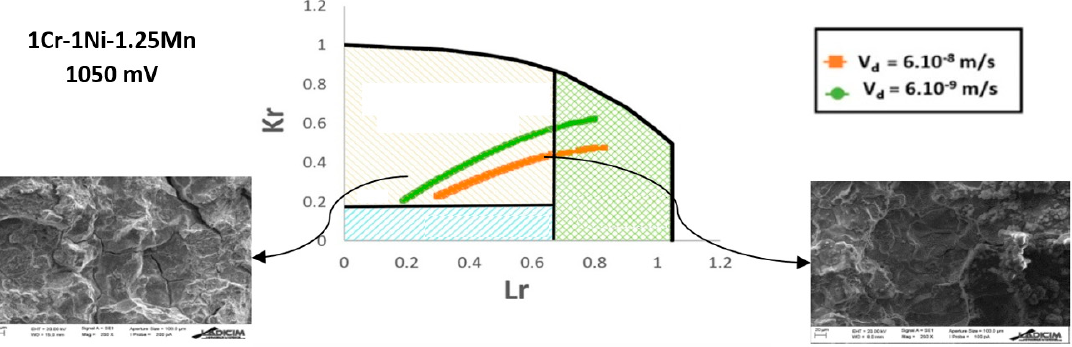
Figure 20. Crack path propagation displayed on the FAD, and fractography, from the slow rate tests performed on 1Cr-1Ni-0.25Mn steel under 1050 mV CP environment at 6 × 10 − 8 and 6 × 10 − 9 m / s.